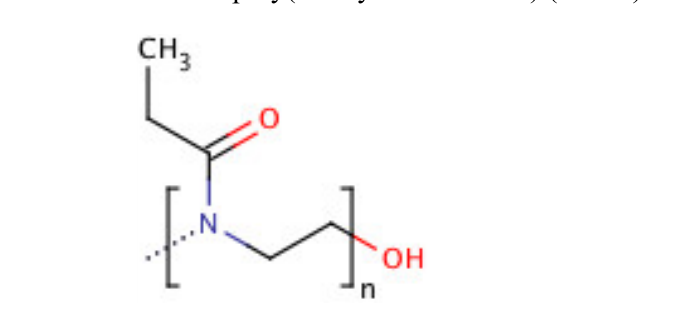
Figure 6. The structure of poly(2-ethyl 2-oxazoline)